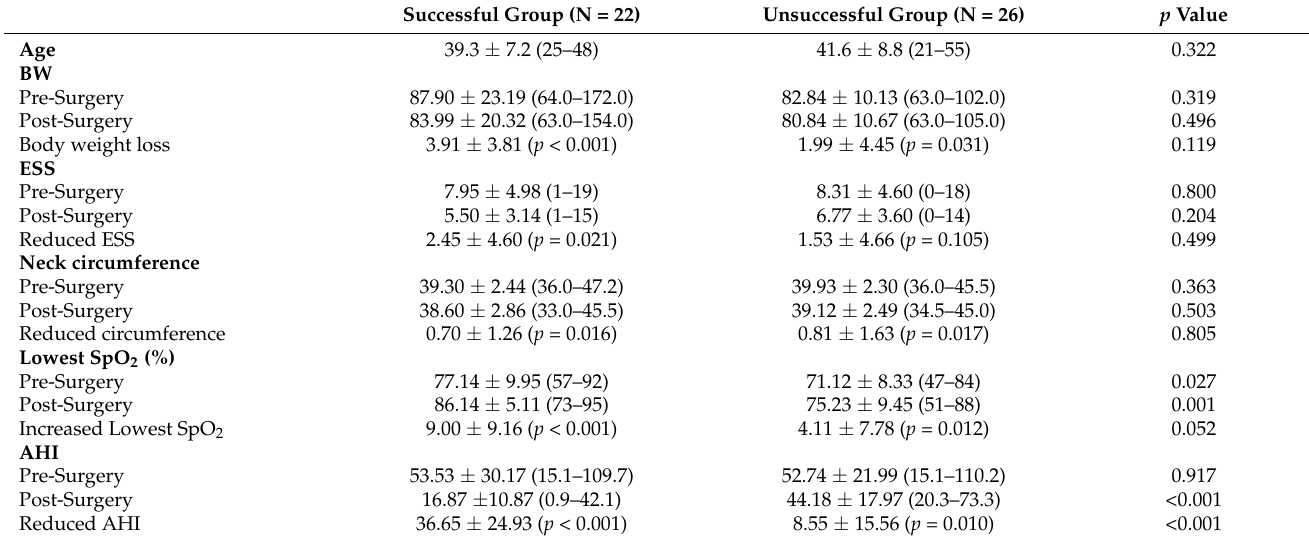
Table 4. Postoperative changes in the successful TORS and unsuccessful TORS